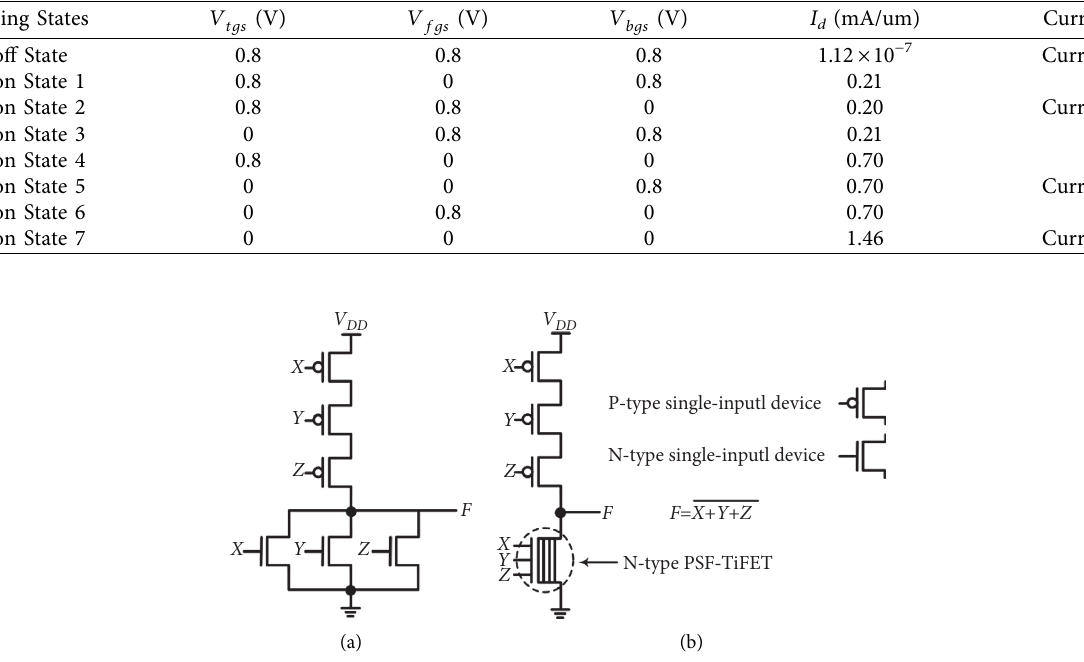
Table 3: The turn-on current and turn-off currents of the P-type PSF-TiFET.